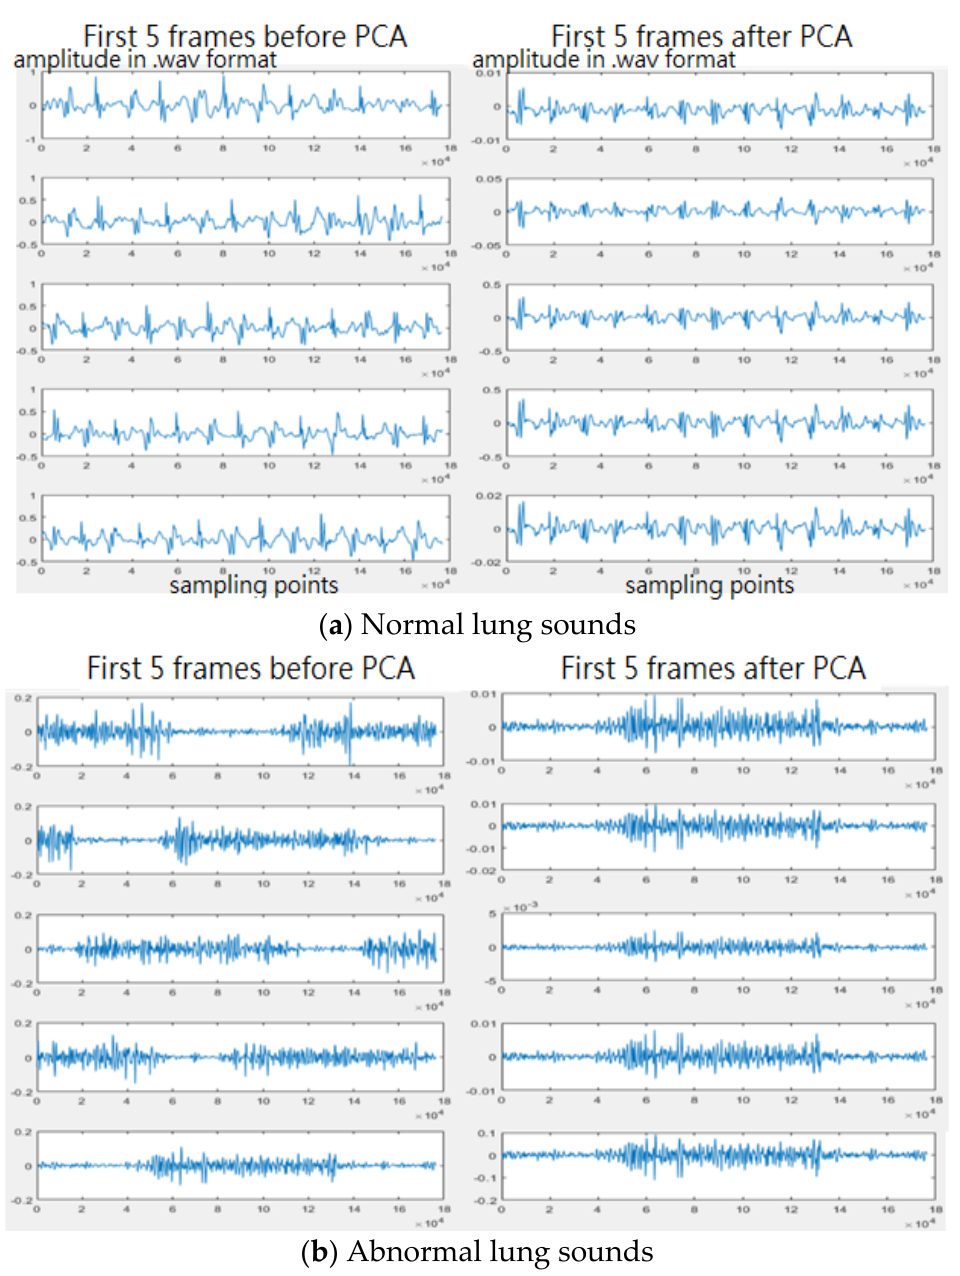
Figure 10. ( a ) Normal lung sounds before/after PCA and ( b ) abnormal lung sounds before/after